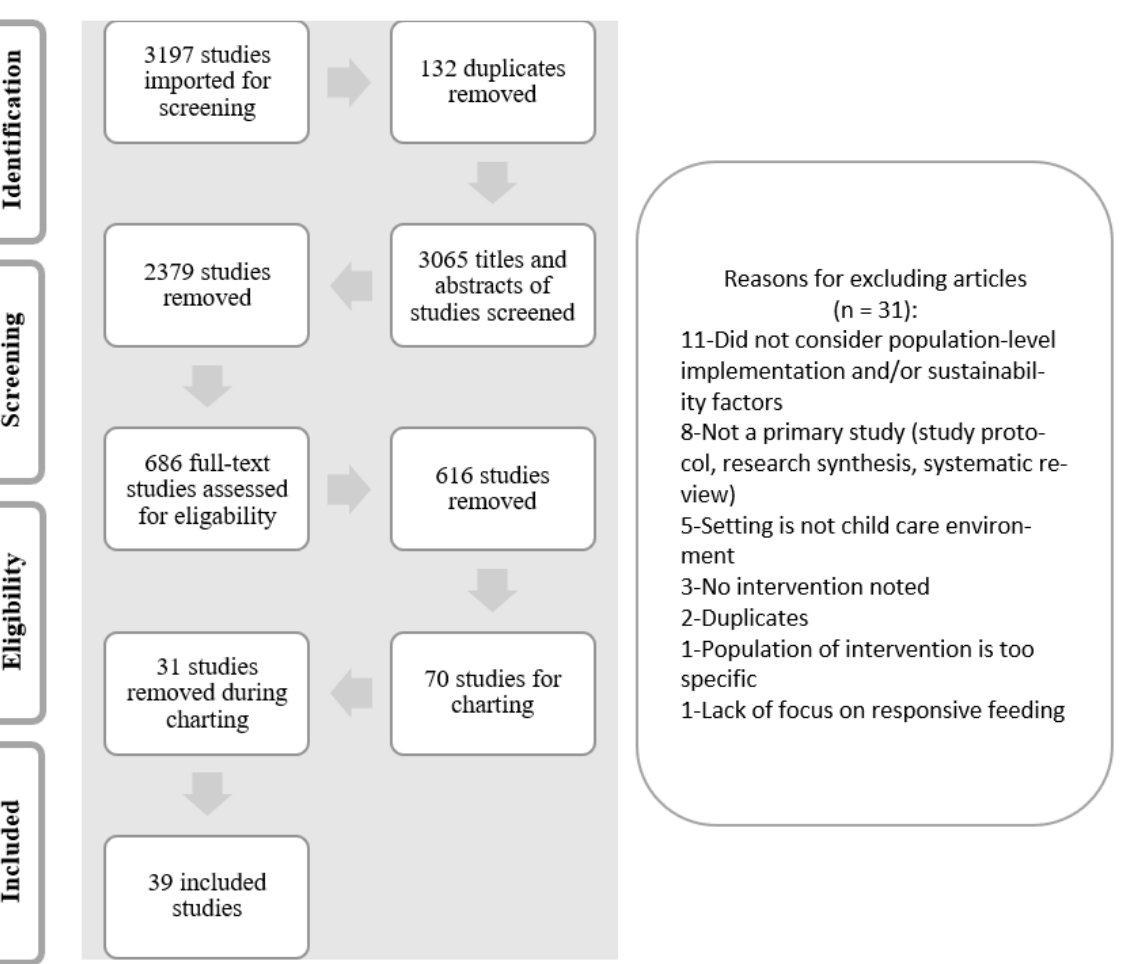
Figure 2. PRISMA Chart of Search Results.